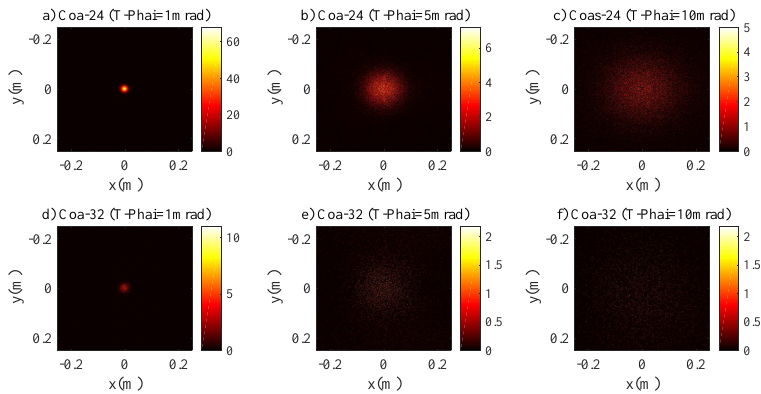
Figure 10. The 2D intensity distribution of the laser beam for coastal seawater channel ( a ) Coa-24 with T-Phai = 1 mrad, ( b ) Coa-24 with T-Phai = 5 mrad, ( c ) Coa-24 with T-Phai = 10 mrad, ( d ) Coa-32 with T-Phai = 1 mrad, ( e ) Coa-32 with T-Phai = 5 mrad and ( f ) Coa-32 with T-Phai = 10